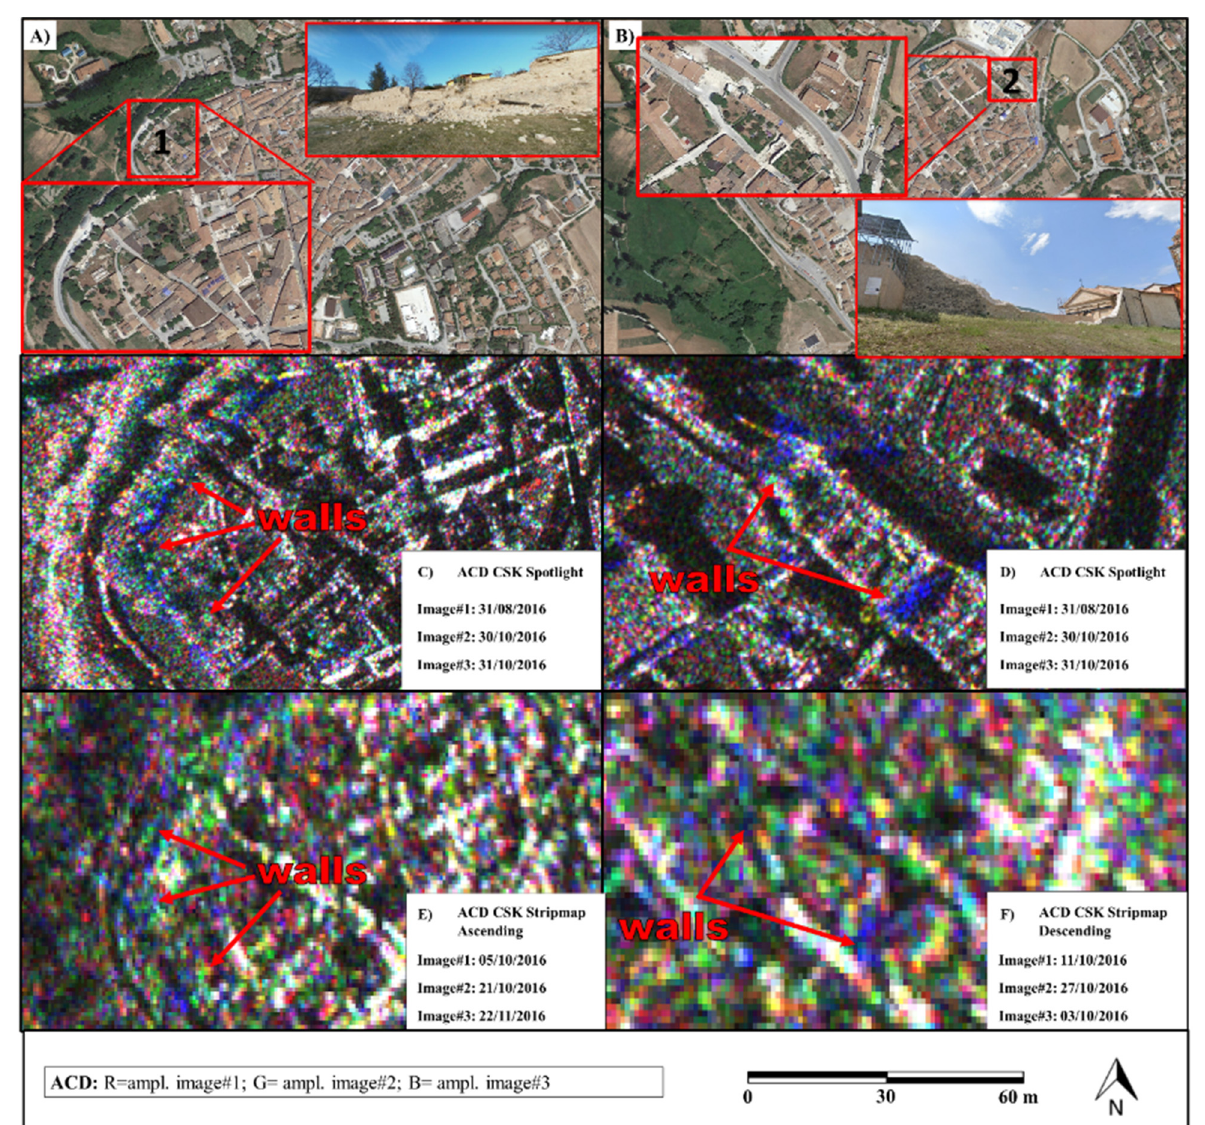
Figure 7. Extracts of two portions of the ancient walls of Norcia [source: Google maps in ( A , B )]. ( A , C , E ) show the locations and ACD results of the northwestern sector of the walls. ( B , D , F ) show the locations and ACD results of the eastern sector of the walls.